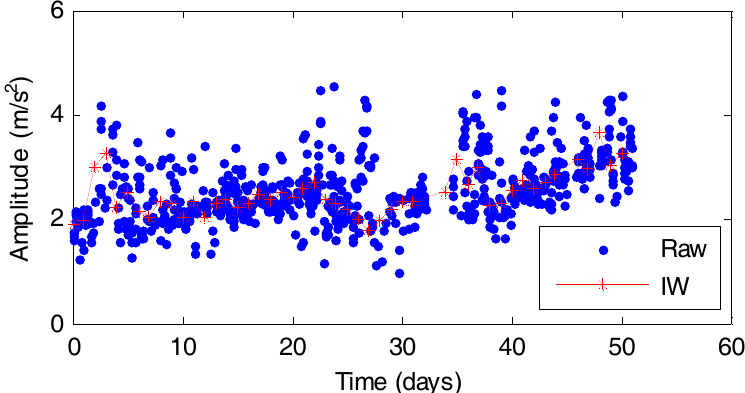
Figure 6. The raw and IW method processed normal WTGB vibration RMS values.